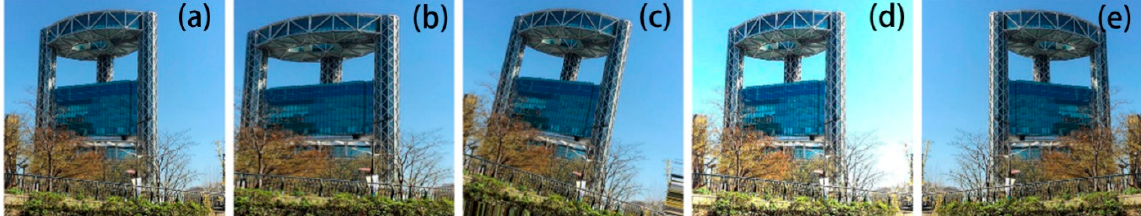
Figure 7. An example of photo effect: ( a ) original; ( b ) zooming; ( c ) rotation; ( d ) brightness; and ( e ) horizontal flip.